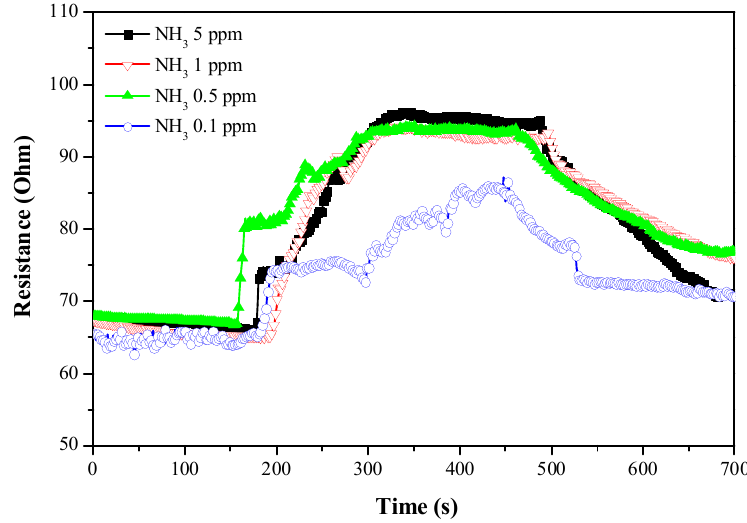
Figure 8. Dependence of resistance on time for the P3HT-ZnO naowires devices which the P3HT films were produced by the spin coating in 4000 rpm.